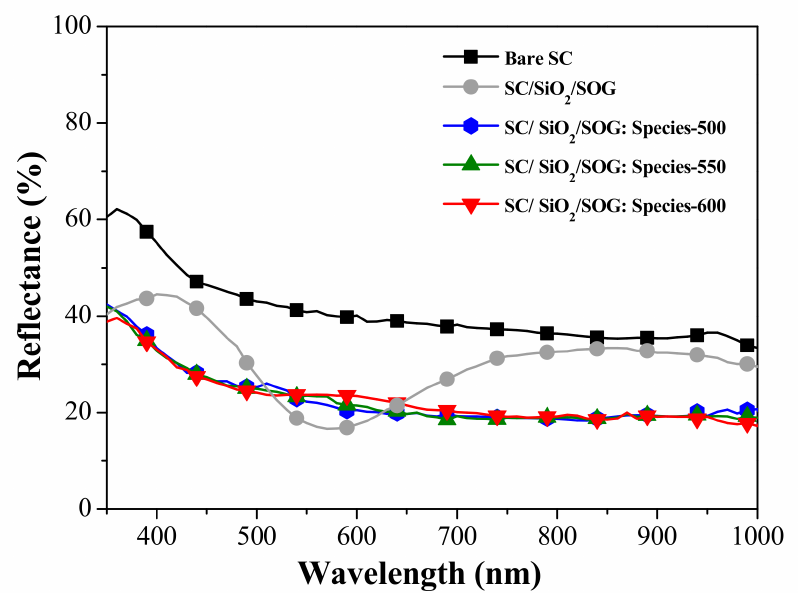
Figure 8. Optical reflectance spectra of bare silicon solar cell, cell spacer/SOG, and cells with spacer/SOG-phosphors (species-500, species-550, and